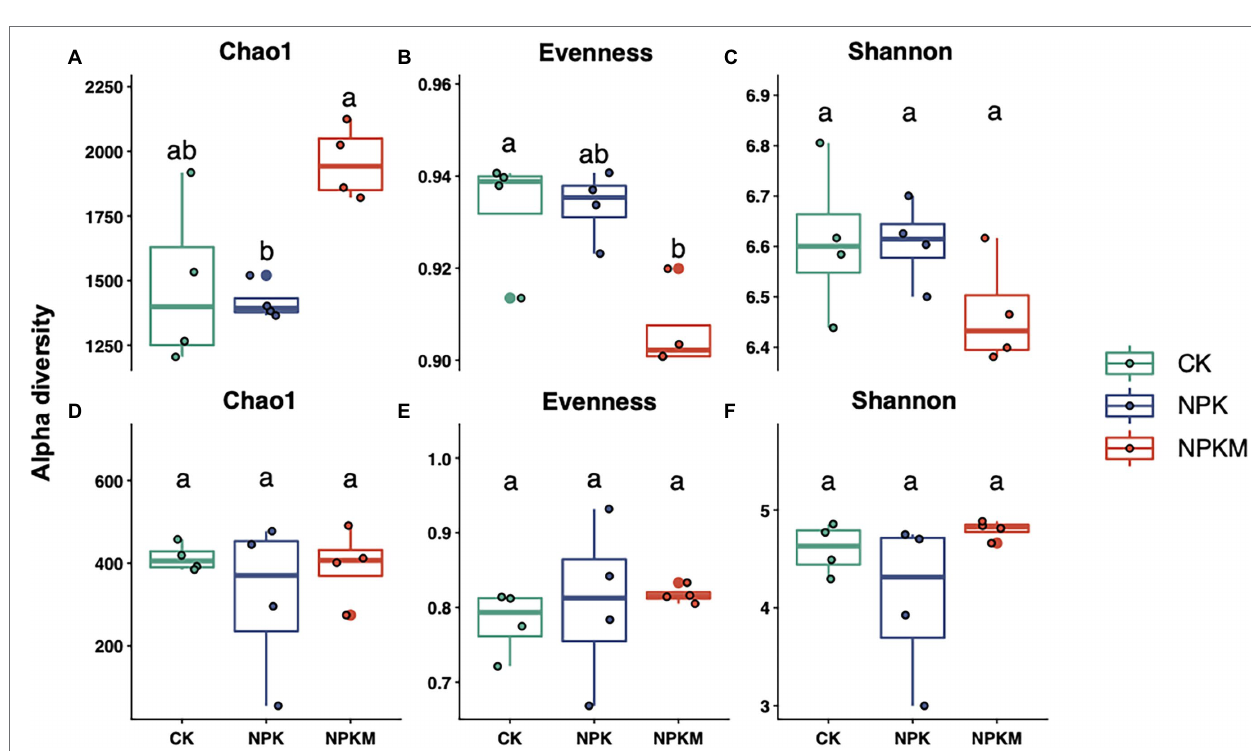
FIGURE 1 | Effects of long-term fertilization treatments on rice yield. Different letters indicate significant differences among treatments (Tukey’s post hoc test, p <